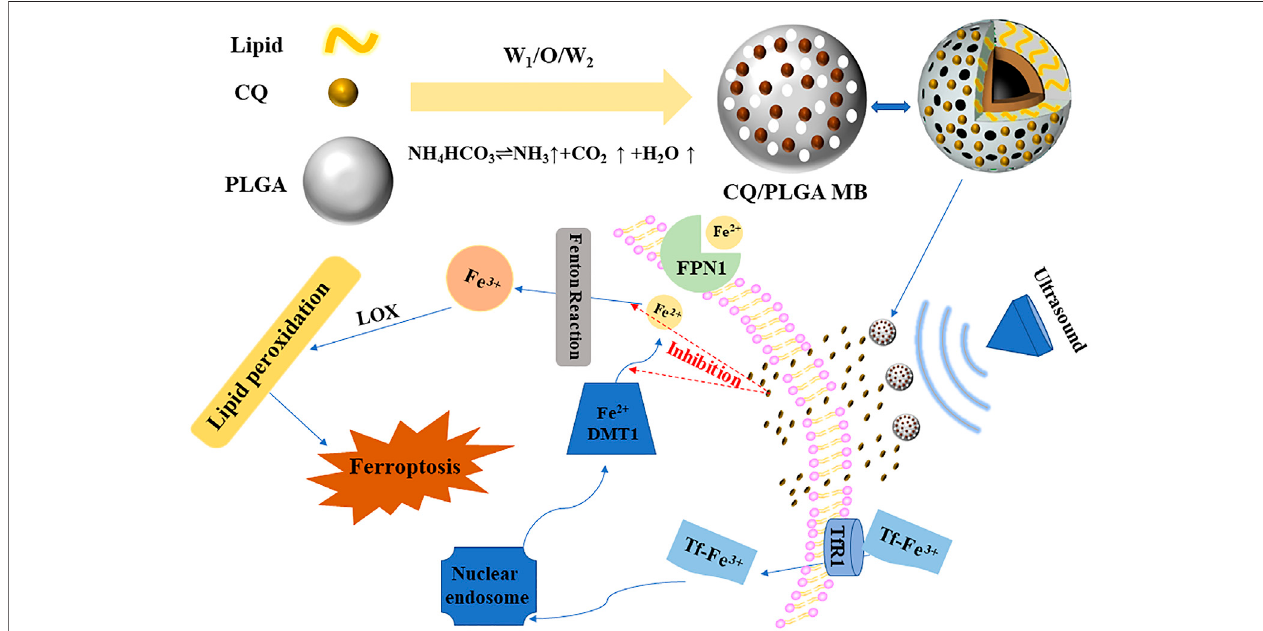
FIGURE1| UltrasoundcombinedwithCQ/PLGAMBsinhibitedtheferroptosispatternofmousecardiomyocytes.Undertheactionofultrasound,the “ steady-state cavitation effect ” of CQ/PLGA MBs caused the increase in cell membrane permeability of HL-1 cells in a short period of time. At the same time, CQ/PLGA releases CQ, and CQ enters the cell through the open space of the cell membrane and binds to Fe 2+ ions, blocking the occurrence of ferroptosis in HL-1